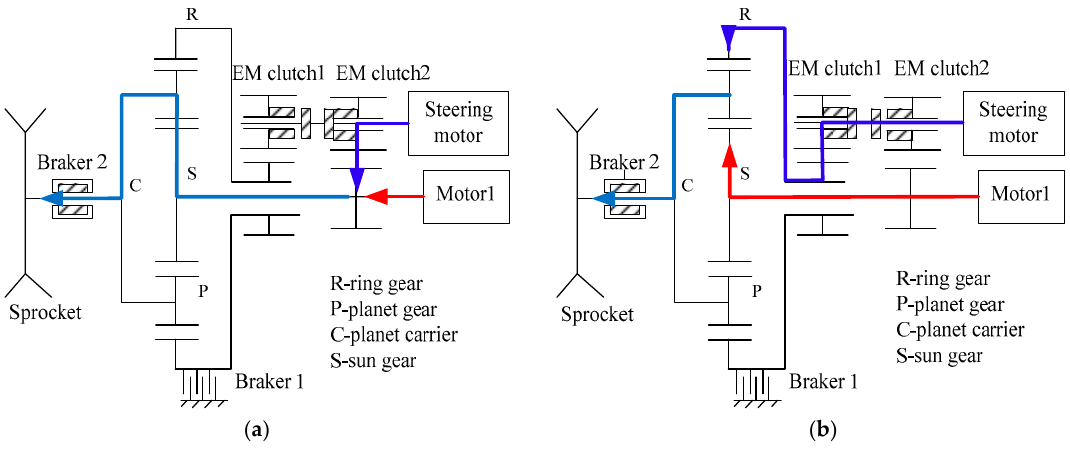
Figure 4. ( a ) Torque coupling transmission mode; ( b ) Power coupling transmission mode.